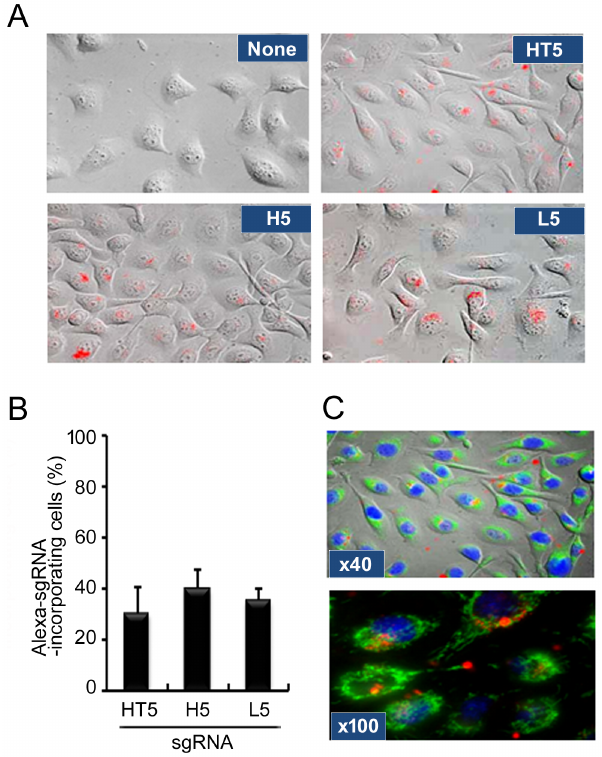
Figure 2. Confocal microscopic analysis for uptake and intracellular localization of sgRNA. (A) HSC-3 cells were plated and cultured for 24 h. Naked Alexa568-3 9 -labeled sgHT2, sgH5 or sgL5 was added at 200 nM and then cells were cultured for a further 24 h, after which the cells were observed by confocal microscopy as described in Materials and Methods. (B) Red fluorescent cells were counted under a fluorescence microscope and the percentage of stained cells was calculated. Each assay represents a separate experiment performed in triplicate. Data are presented as means ¡ S.D. (C) HSC-3 cells were treated with naked Alexa568-3 9 -labeled sgHT5 and then labeled with Mitotracker Green and Hoechst33342 to visualize mitochondria and nuclei, respectively. Cells were observed through a 40x objective lens (upper panel) or 100x objective lens (lower panel) of the